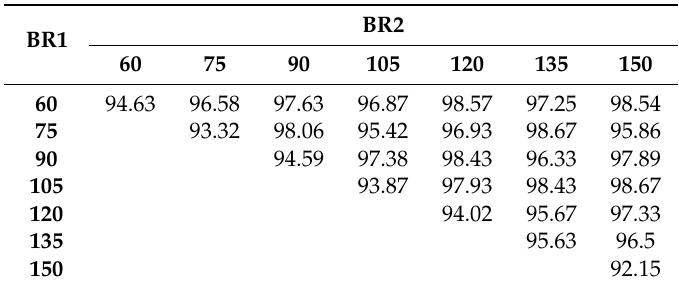
Table 4. Feature fusion F 1 value detection results—FAAC